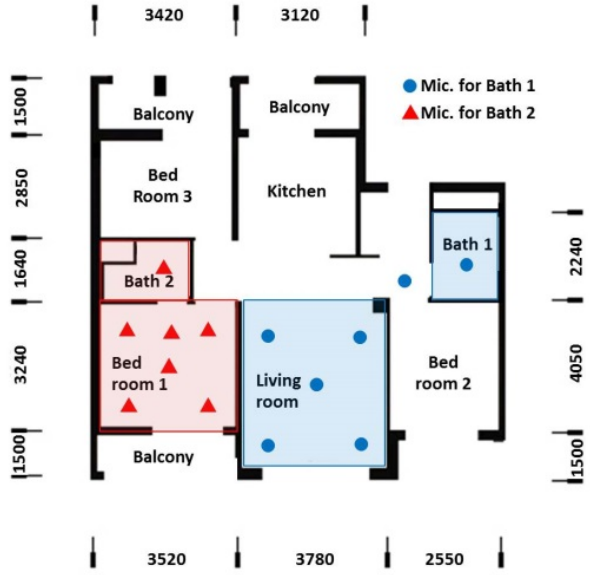
Figure 3. Illustration of the experimental setup for the measurement in the bathroom and adjacent rooms of the lower floor (59A type).